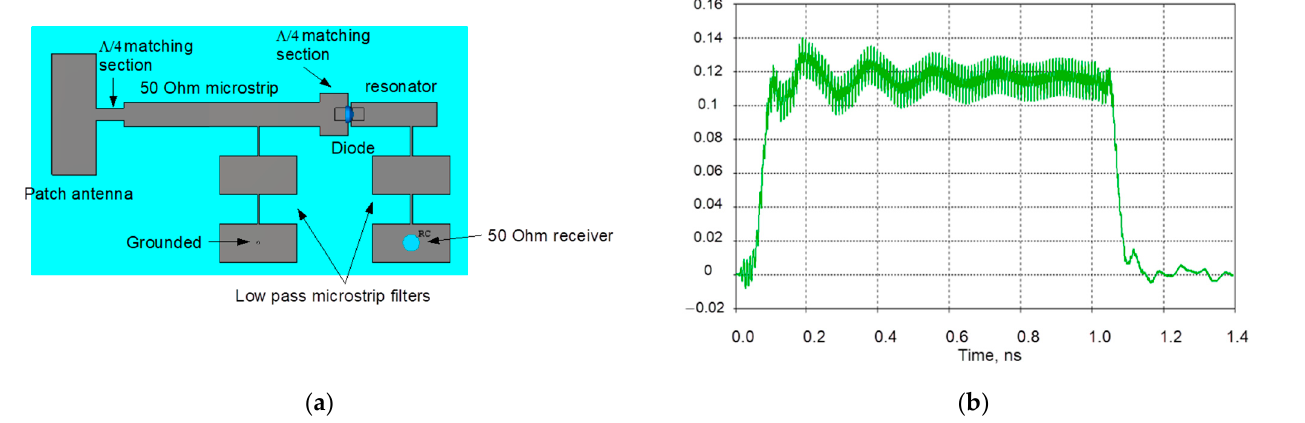
Figure 2. Front view of the PCB microwave detector and its components ( a ). The pattern is fabricated by applying a photomask and copper etching followed by ENIG or silver plating/dipping. The simulated envelope signal on the detector is shown in ( b ).